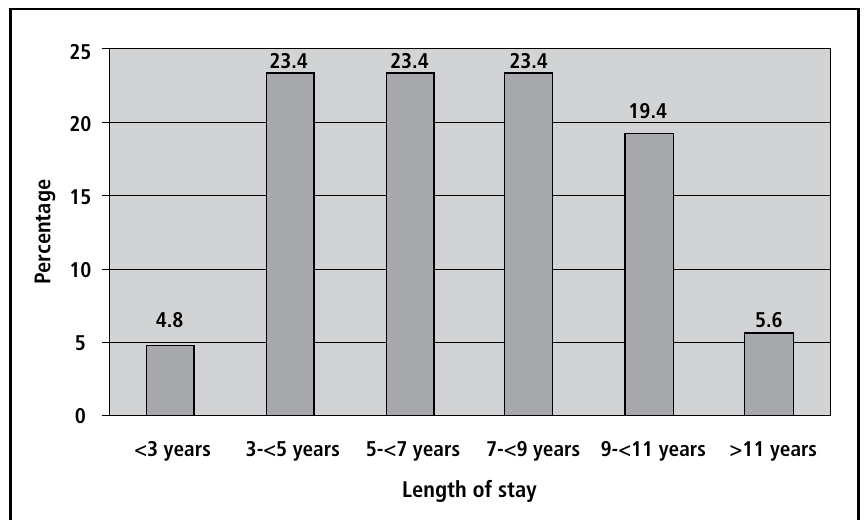
Figure 1: Length of hospital stay among the